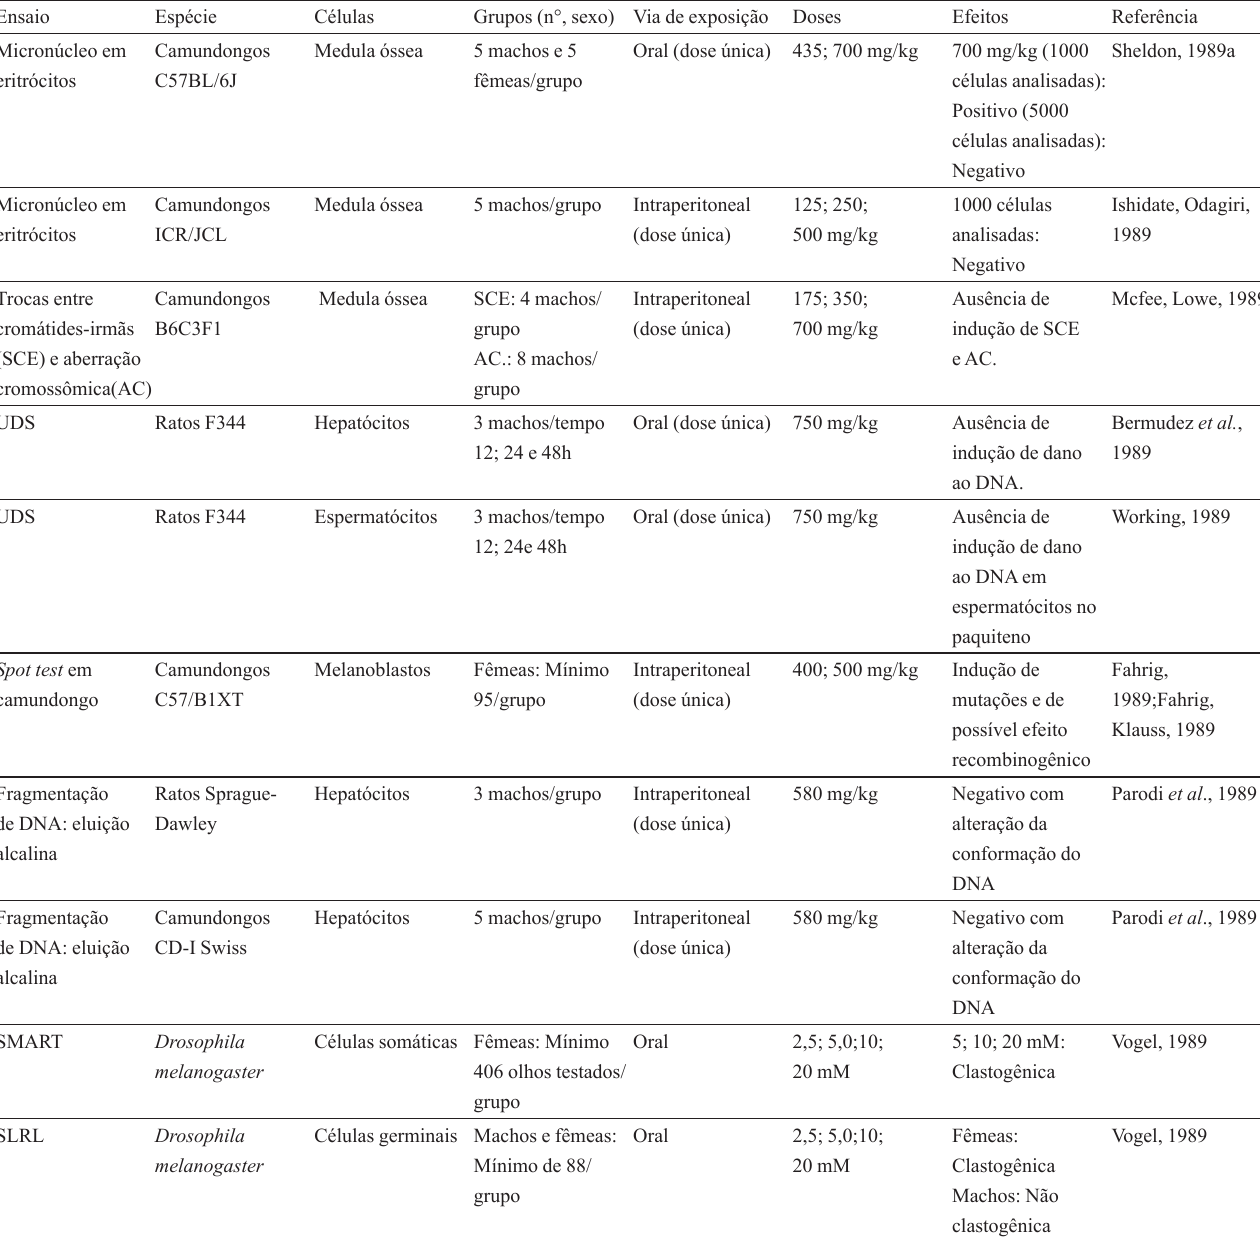
TABELA IV - Estudos da genotoxicidade in vivo da